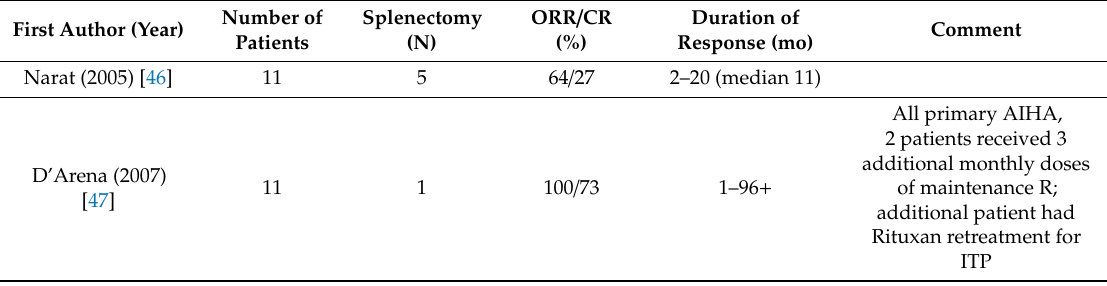
Table 1. Retrospective trials of rituximab in relapsed/refractory warm autoimmune hemolytic anemia (wAIHA).